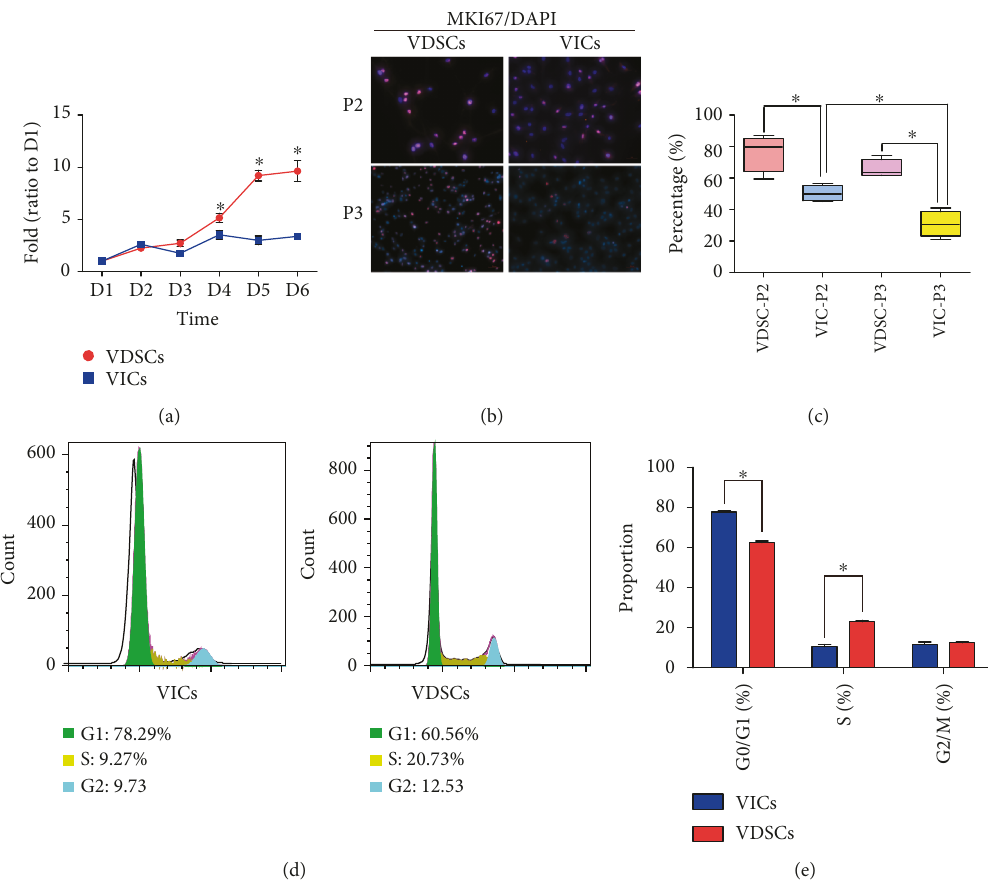
Figure 2: Cell proliferation ability comparison between VICs and VDSCs. (a) Cell proliferation curves show the di ff erence between VDSCs and VICs; ∗ p < 0 05 (vs. VICs) are accepted as having signi fi cant di ff erence, n = 3 . (b) MKI67 immuno fl uorescent staining, and nuclei are stained with DAPI. (c) The cartogram (based on (b)) shows the di ff erences between passage 2 and passage 3 of VDSCs and VICs; ∗ p < 0 05 are accepted as having signi fi cant di ff erence, n = 4 . (d) FACS analysis for the cell cycle of VDSCs and VICs; (e) S, G0/G1, and G2/M phases were counted and statistically compared. ∗ p < 0 05 (vs. VICs) are accepted as having signi fi cant di ff erence, n = 4